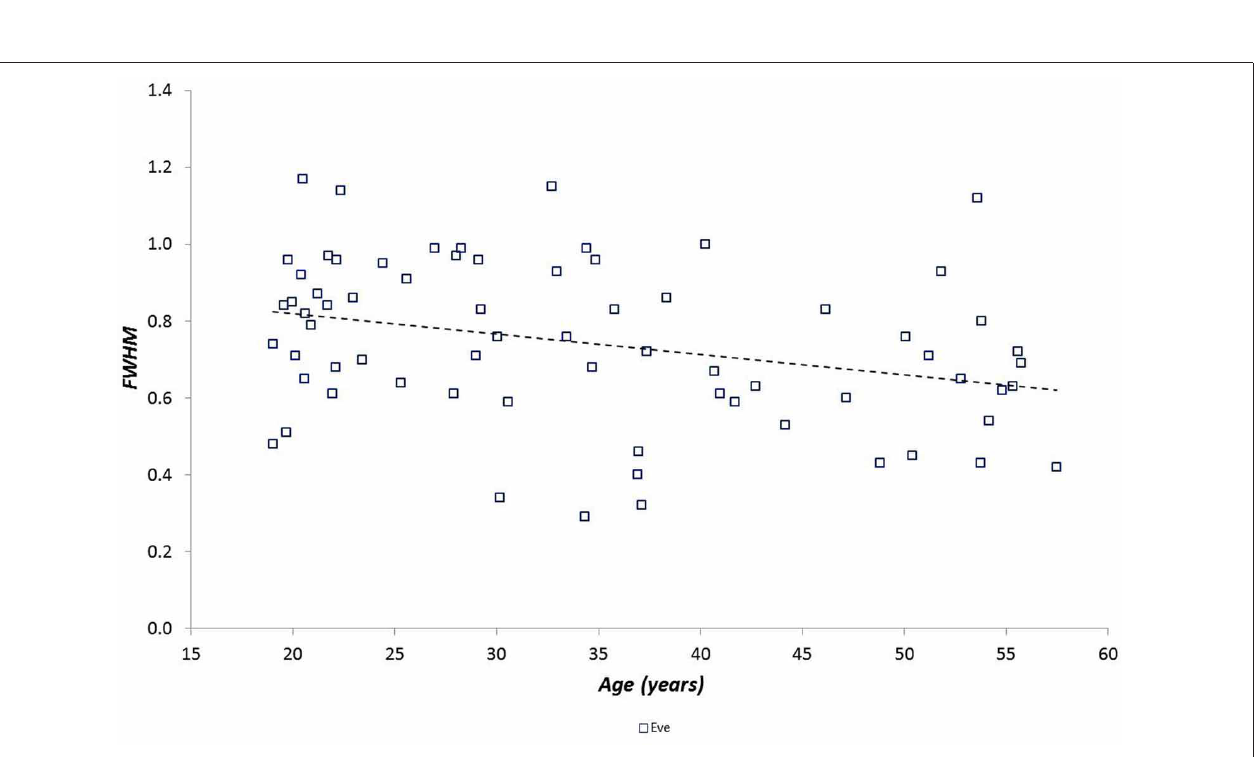
Frontiers in Physiology | Fractal Physiology May 2013 | Volume 4 | Article 100 |